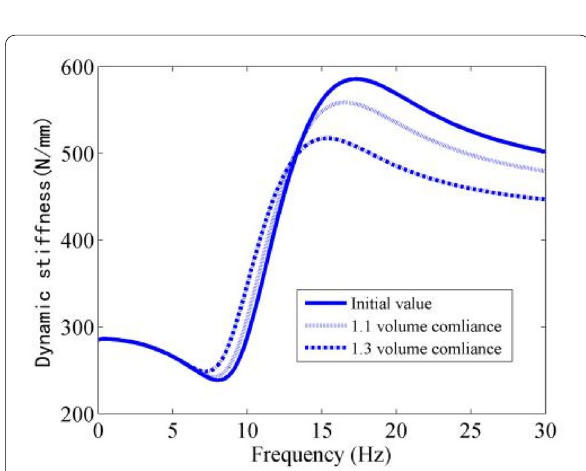
Figure 16 Dynamic stiffness vs. frequency curves for different volume compliances